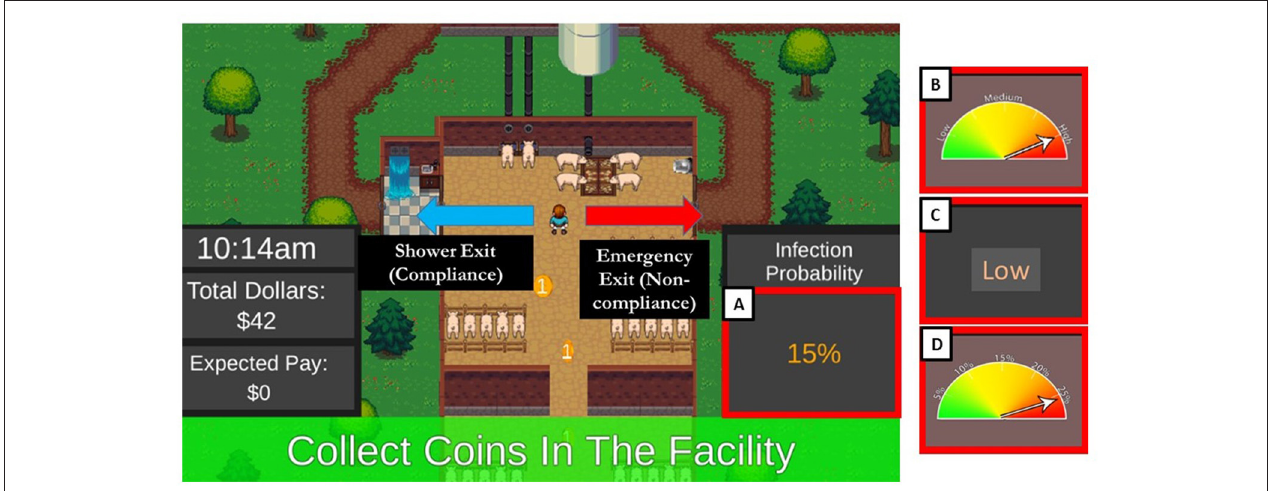
FIGURE 1 | Depicted is the decision point during the experiment. This screen grab shows (A) the Numeric risk message format as the current treatment. Additional treatment formats used to depict risk are displayed on the right: (B) Linguistic Threat Gauge, (C) Linguistic phrase, and (D) Numeric Threat Gauge message format.